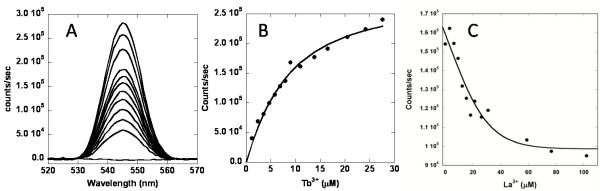
Metal binding studied by Tb3+-FRET. (A) The fluorescence enhancement at 545 nm with increasing concentrations of Tb3+ in 5 μM of EEDDN in 20 mM PIPES, 10 mM KCl pH 6.8. (B) Determination of Tb3+ binding affinity of EEDDN by analyzing the dependence of the fluorescent intensity change on Tb3+ concentration. The solid line is the fitted curve. (C) Decrease in fluorescence by the addition of La3+ into a fixed concentration of Tb3+ and EEDDN. This data was analyzed to obtain Kd for La3+.